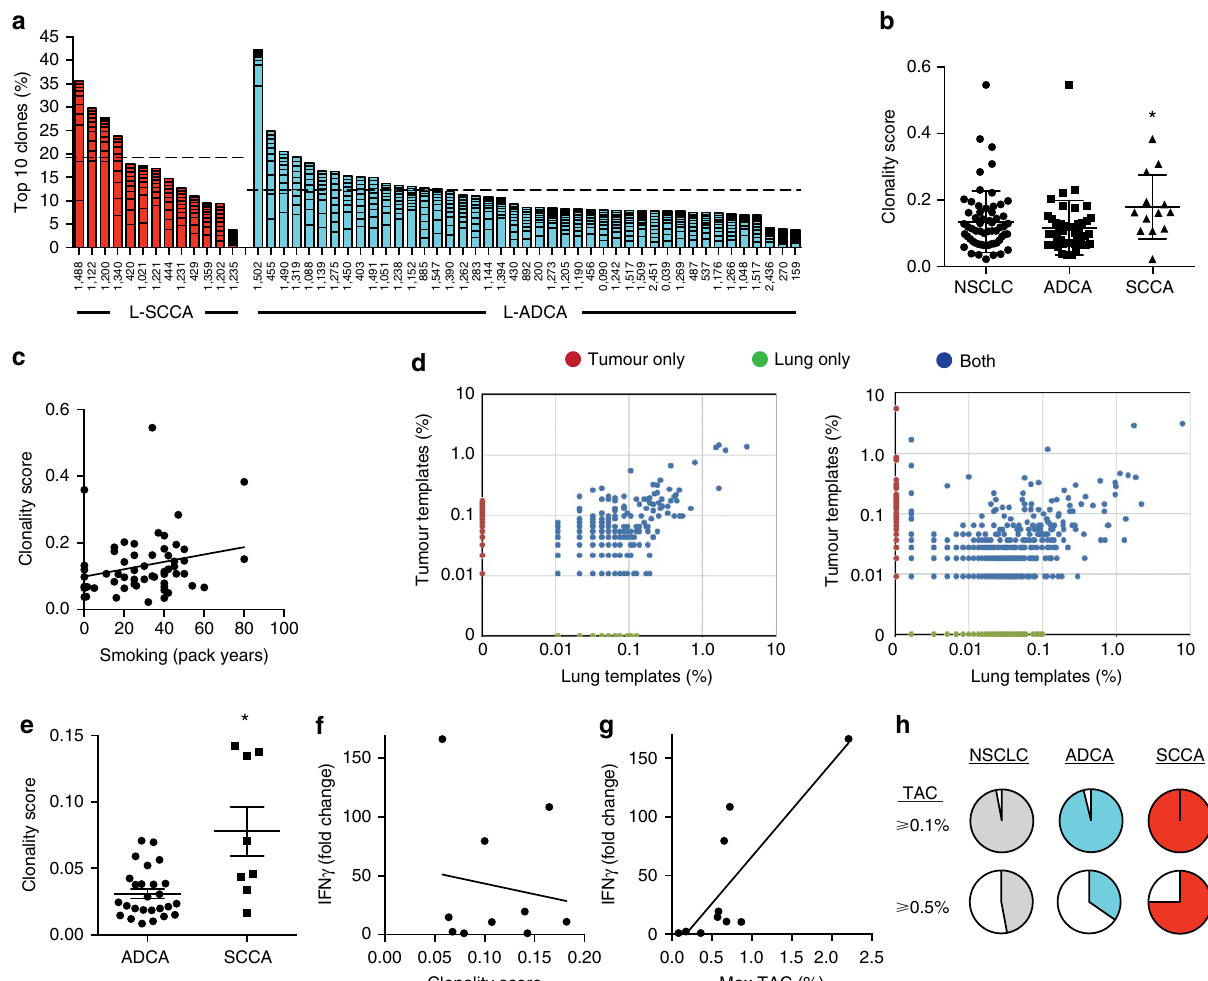
Figure 1 | Expansion and specificity of TCR- b repertoire in NSCLC. ( a ) Frequency of TCR- b Top 10 Clones (mean ¼ dotted line, L-SCCA (red) versus L-ADCA (blue), * P ¼ 0.0133) were analysed using Adaptive Biotechnologies TCR sequencing platform ( N ¼ 56). Frequency of Top 10 clones is comprised of 10 most expanded clones from each specimen (represented as stacked bar graph). ( b ) Productive clonality score (L-ADCA versus L-SCCA, * P ¼ 0.0226, N ¼ 60) and ( c ) linear correlation of productive clonality score and smoking consumption (pack year) ( P ¼ 0.0821, R 2 ¼ 0.0540, N ¼ 58). ( d ) Representative scatter plots for matched lung-tumour specimen with no expanded tumour TAC (left) and expanded TAC (right). TACs were defined as clones only found in tumour specimen (red) but not in matched lung specimen (green). ( e ) Clonality score was calculated for TAC (L-ADCA versus L-SCCA, * P ¼ 0.0004, N ¼ 34). ( f ) Linear correlation of productive clonality score and TIL IFN g production ( P ¼ 0.6684, r 2 ¼ 0.0241, N ¼ 10) and ( g ) linear correlation of maximum (max) TAC and TIL IFN g production ( P ¼ 0.0035, r 2 ¼ 0.6357, N ¼ 10). ( h ) Patients with TAC for NSCLC, L-ADCA and L-SCCA. TACs were defined as clones only present in tumour expanded more than X 0.1% (top row) and X 0.5% (bottom row). Student’s tests were performed to compare two groups ( a , b , e ) and Pearson correlation calculations were performed for linear correlations ( c , f , g ). Each data point represents one patient sample and data are presented as mean ± s.e.m., * P o Table 1). We employed a flow cytometry panel composed of 27 markers (Supplementary Table 2) that can identify 51 unique immune cell types and functional subpopulations using single-cell suspensions generated from lung cancer tissue and non-adjacent lung tissue (as far removed from the tumour lesion as possible, at least 3 cm). The gating strategy is depicted in Fig. 2a, and the details of tissue processing, staining, gating, data analysis and statistical analyses are provided in the Methods, Supplementary Figs 1–3, and Supplementary Tables 3–7. The data were analysed in multiple ways, including % live, % CD45 þ , % parent and matched tumour-normal pairs, while accounting for smoking and other clinical features, all of which produced similar results (Supplementary Tables 3–6).